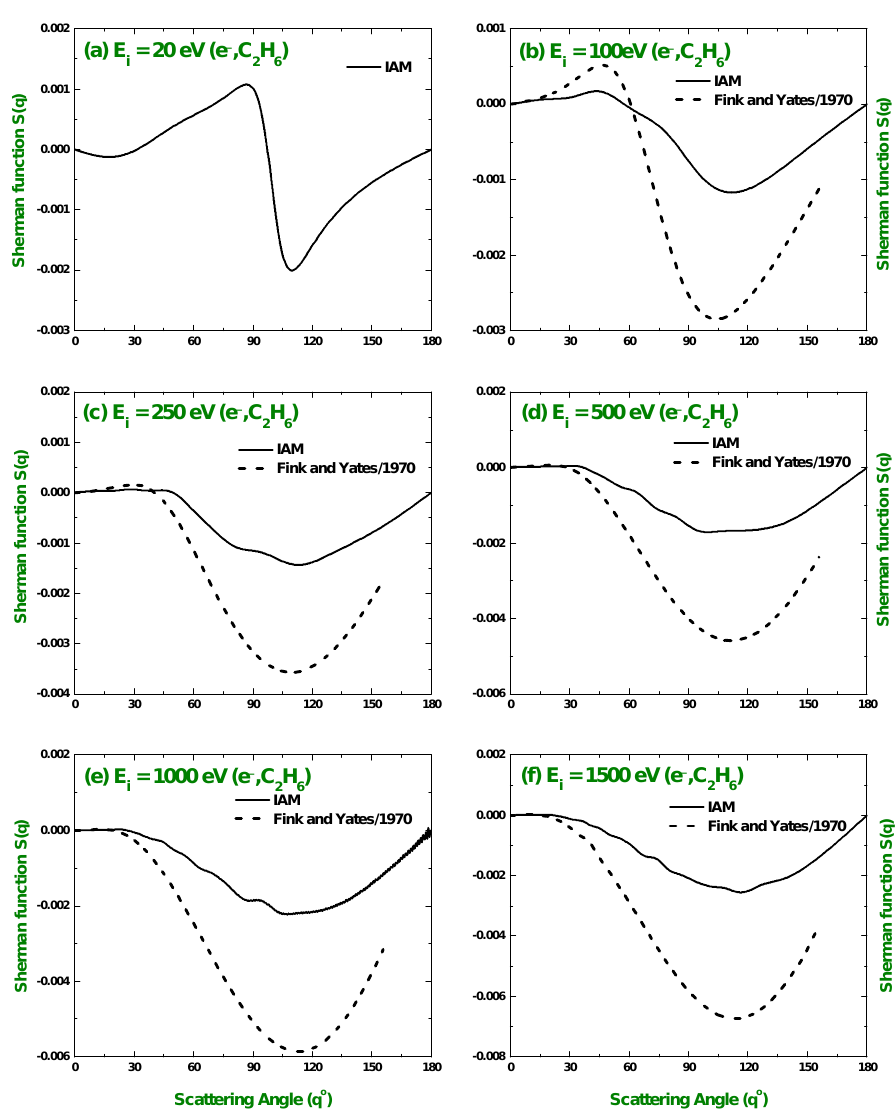
Figure 8. Angular distribution of the Sherman function for the electrons scattered elastically from C 2 H 6 predicted by the IAM approach. Theoretical works: Fink and Yates